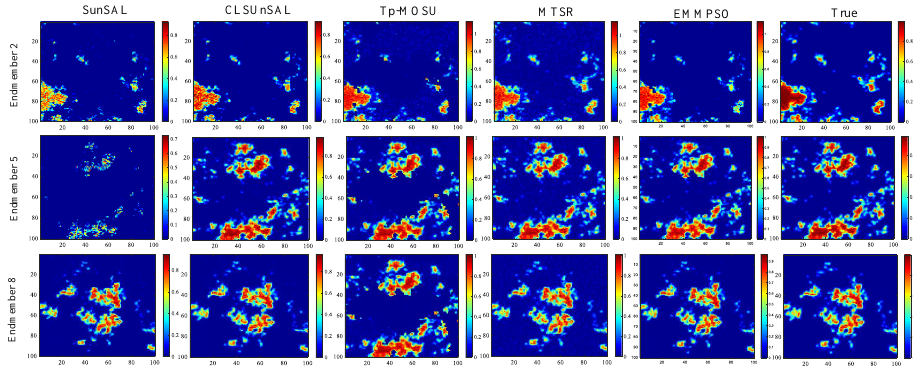
Figure 7. The fractional abundance maps of endmember 2, 5, 8 by SunSAL, CLSUnSAL, Tp-MOSU, MTSR and EMMPSO on Data 1.